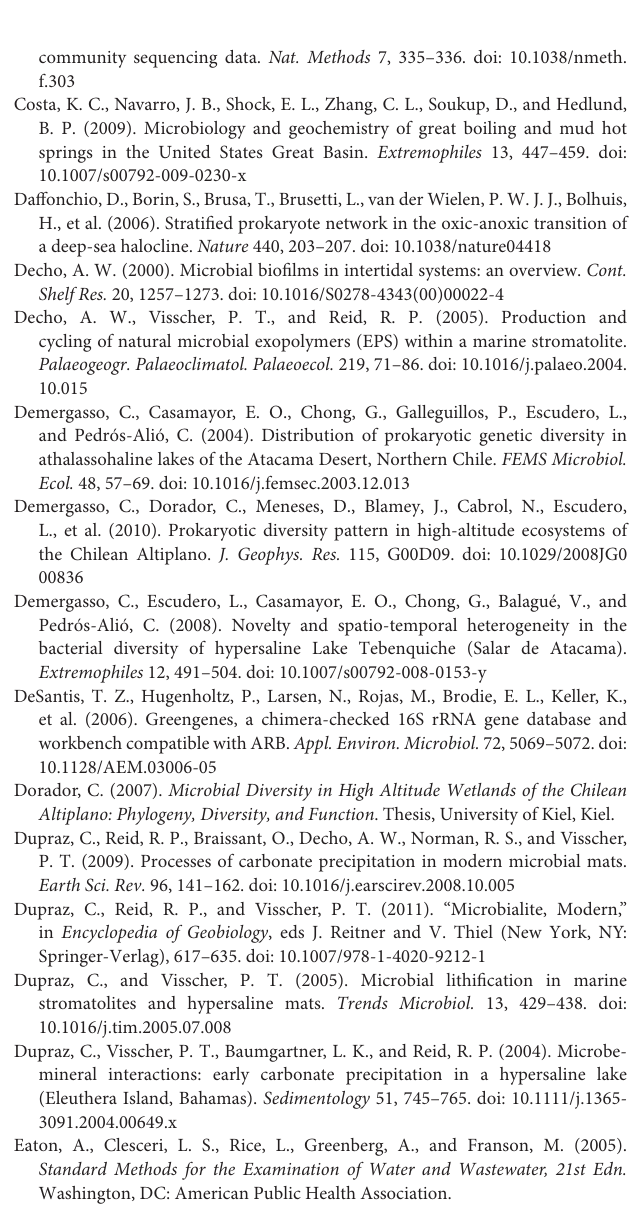
Figure S2 | Rarefaction curves plotting the number of observed OTUs as a function of the number of sequences. (A) Rarefaction curves by layers in MA1. (B) Rarefaction curves by layers in EVD. Table S1 | Physico-chemical parameters for the overlying water from the different samples studied. Table S2 | Observed microbial richness and diversity estimates based on 97% OTU clusters in microbial mats (MA1 and MA2), rhizome-associated lithified mats (RAC1 and RAC2) and evaporite (EVD). Table S3 | Abundant microbial OTUs classified at the lowest possible taxonomic level in MA1. Each OTU contains at less 1% 16S rRNA sequences. Table S4 | Abundant microbial OTUs classified at the lowest possible taxonomic level in EVD. Each OTU contains at less 1% 16S rRNA